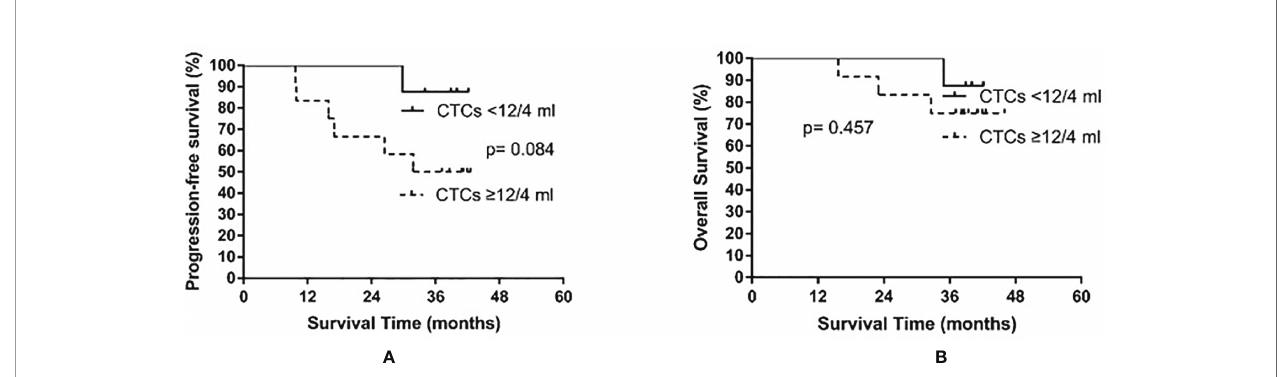
FIGURE 3 | Progression-free survival (A) and overall survival (B) in small cell lung cancer patients according to circulating tumor cell (CTC) count before prophylactic cranial irradiation.